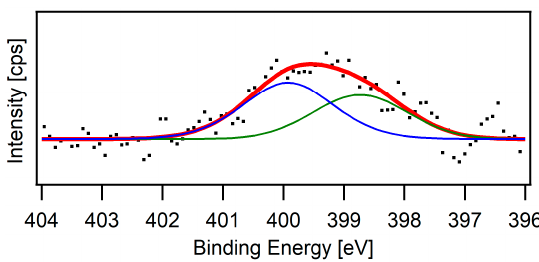
Figure 3. The X-ray photoelectron spectroscopy (XPS) spectrum of N 1 s core level (Mg K α radiation) of the PCL-PPyHA sample (red). Blue and green lines represent two binding modes of the nitrogen atom.